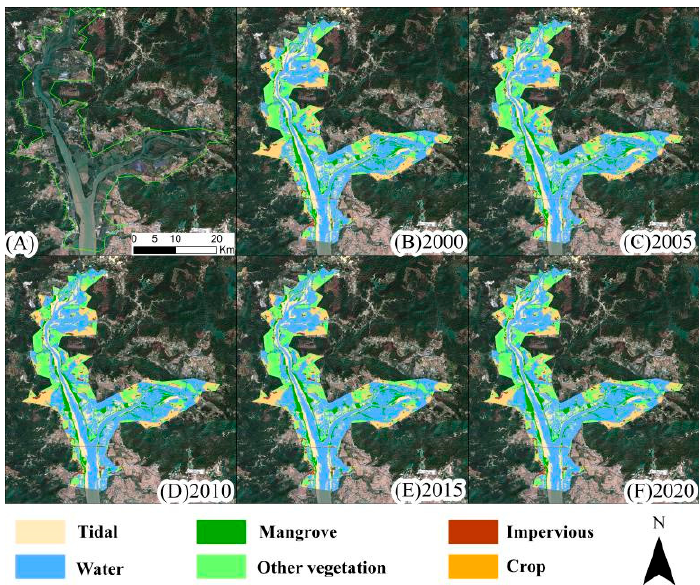
Figure A1. The spatiotemporal changes of mangrove forests in GTZMNWP from 2000 to 2020. ( A ): the image of GTZMNWP, ( B ): 2000, ( C ): 2005, ( D ): 2010, ( E ): 2015, ( F ): 2020.